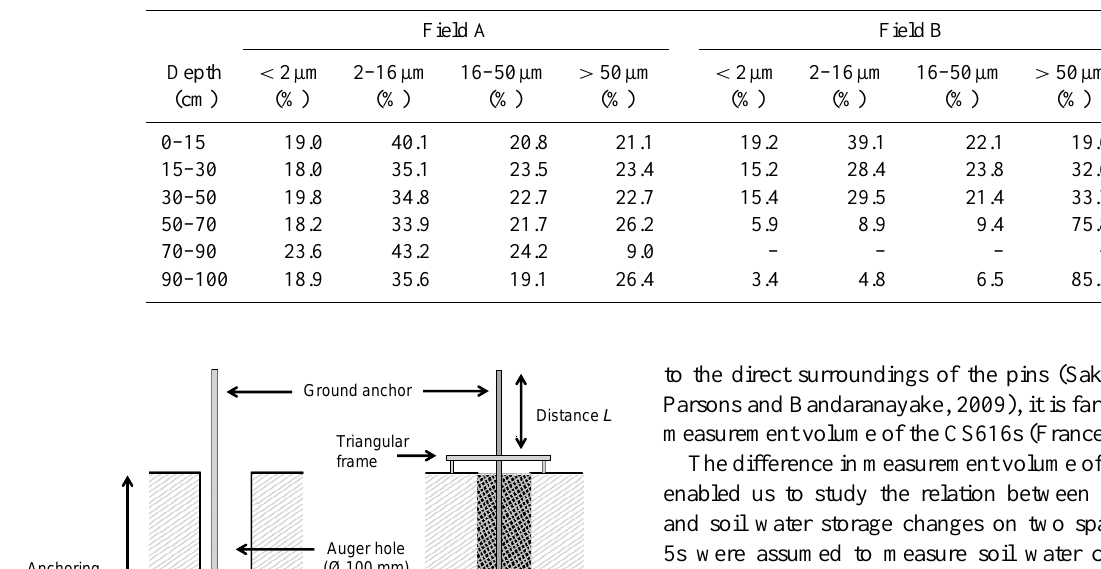
Table 1. Grain size distribution at several depths of soils at field A and field B.